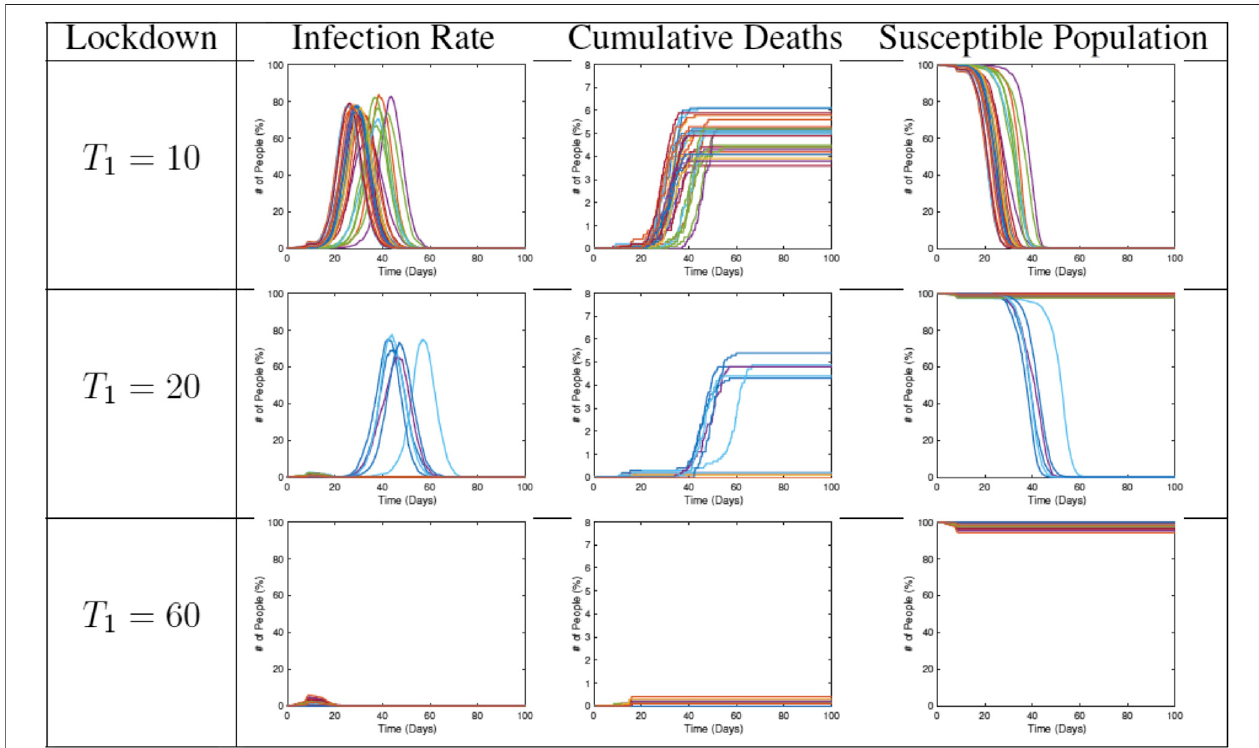
FIGURE13| ResultsfromRAW-ALPSrunsforafulllockdown(LD1)endingatdifferenttimes.Goingfromtoptobottom,wekeepthelockdownsforlongerperiods. A longer imposition of lockdown helps in reducing the spread of the